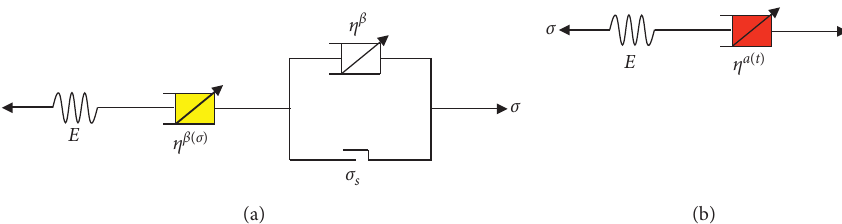
Figure 14: Schematic diagram of the creep model based on fractional derivatives theory (a) proposed by Wang et al. [136] and (b) proposed by Wu et al.